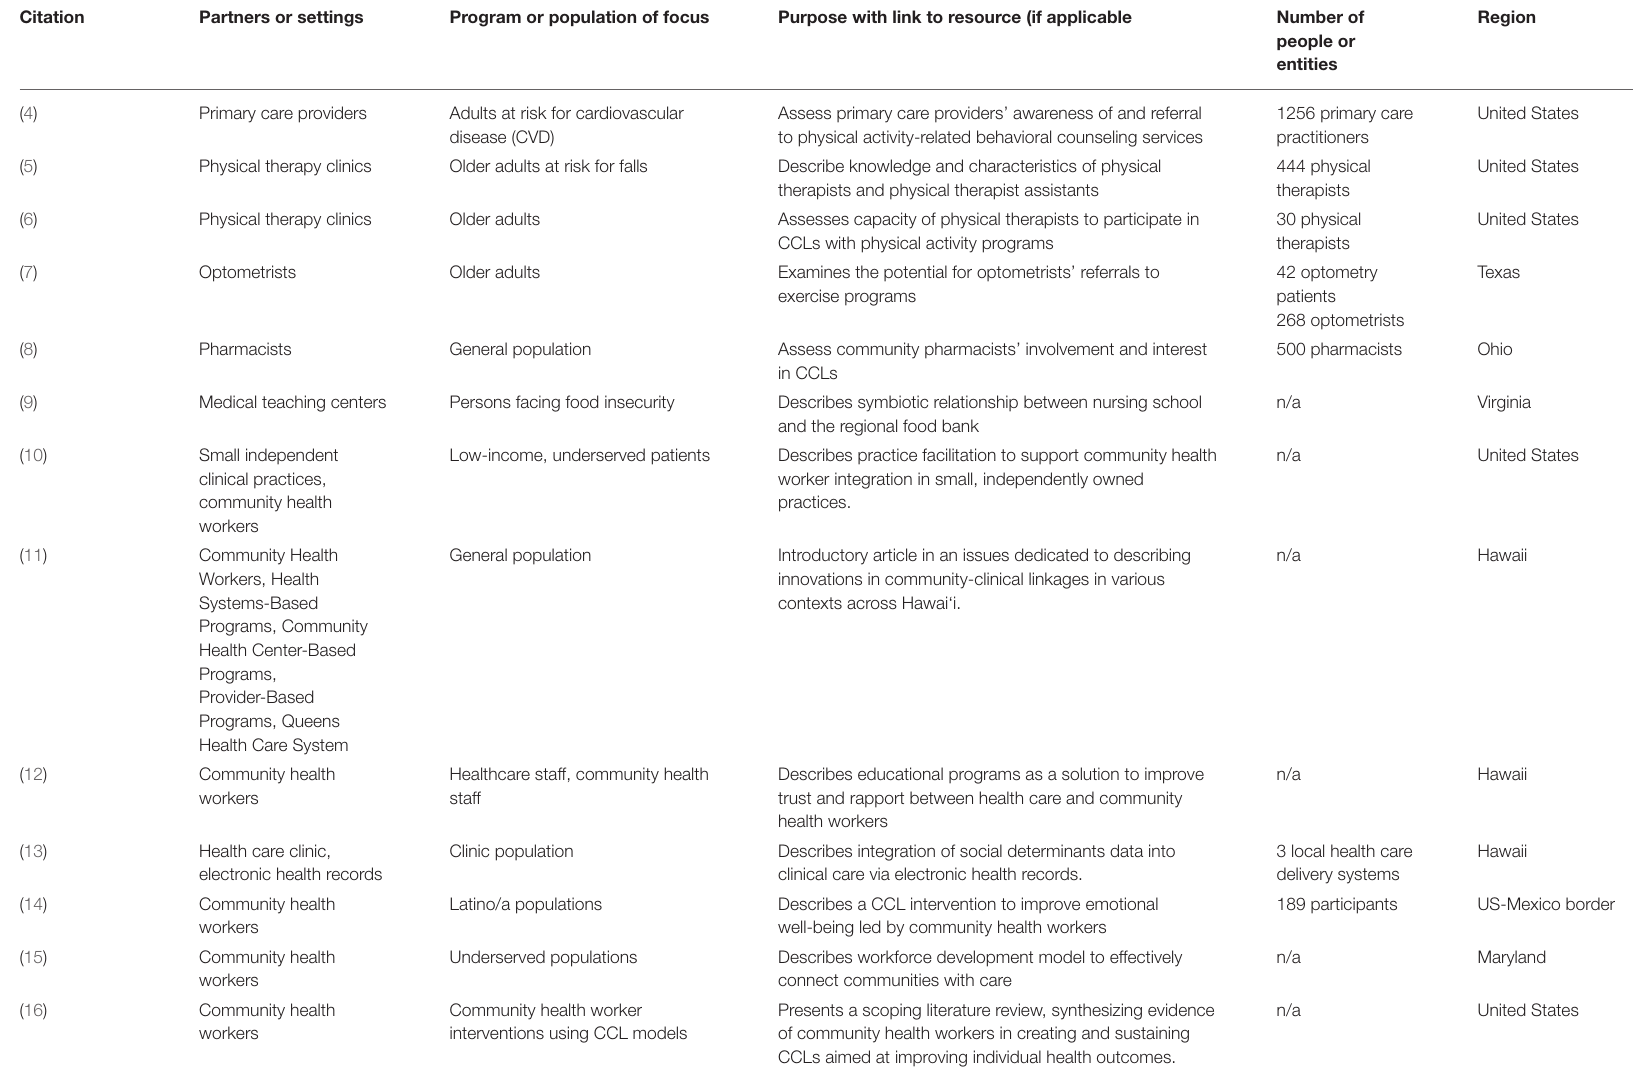
TABLE 1 | Summary of publications included literature